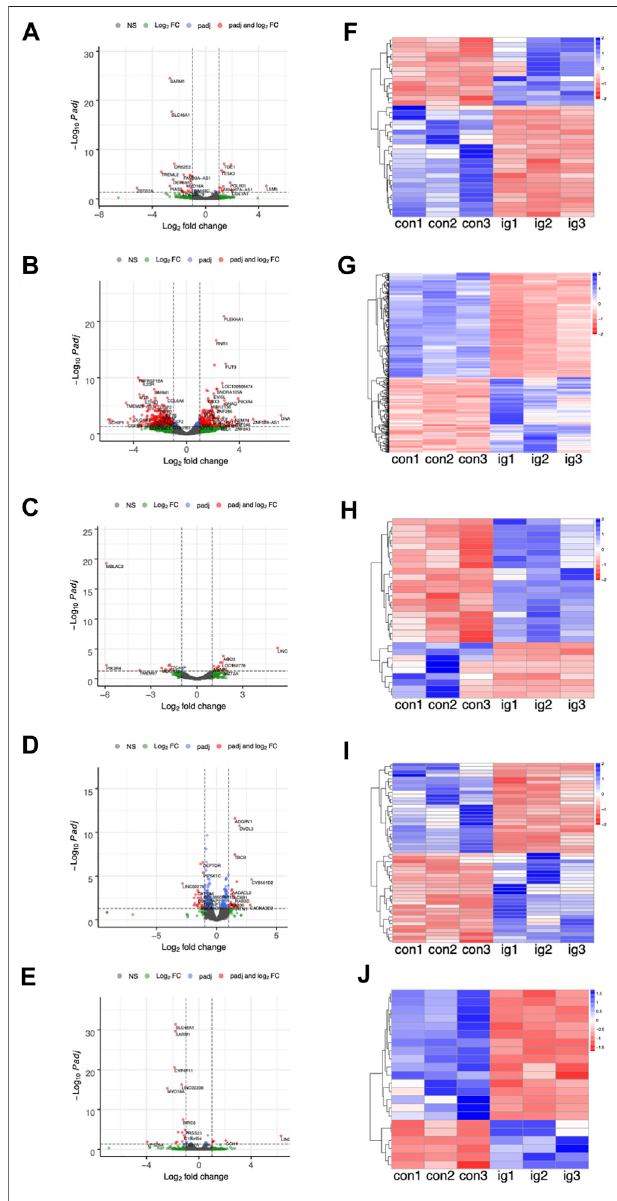
FIGURE 4 | (A – E) The volcano plots of DEGs between the intragastric (i.g.) administration group and control group, for the heart, liver, spleen, lung, and kidneys, respectively. (F – J) The heatmap of